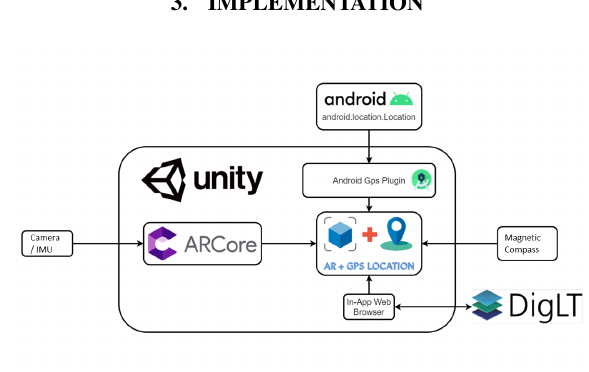
Figure 3. Mobile AR